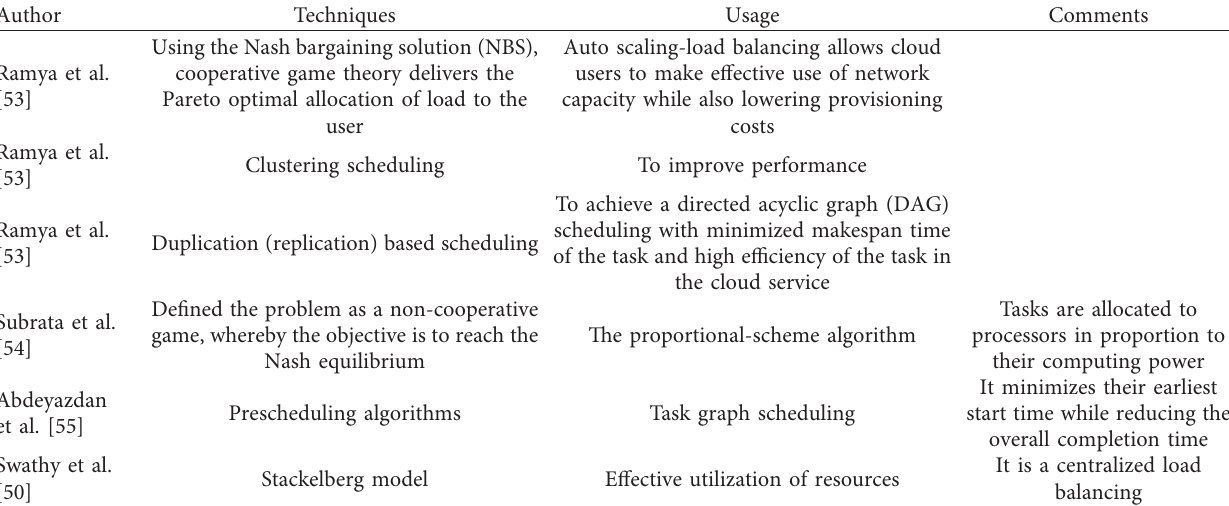
Table 4: A comparative analysis of game-theoretic models for load balancing in cloud architecture.